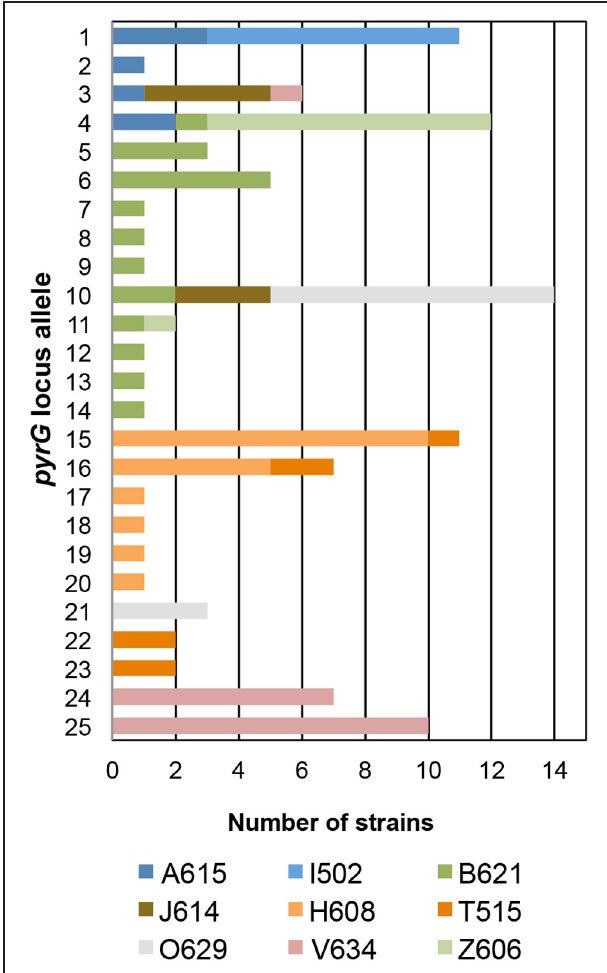
FIGURE 2 | Distribution of pyrG alleles among T. uzonensis isolates. Bars are color coded and correspond to the hot spring from which the T. uzonensis isolates were derived. Geothermal spring abbreviations are given in Table 1 .